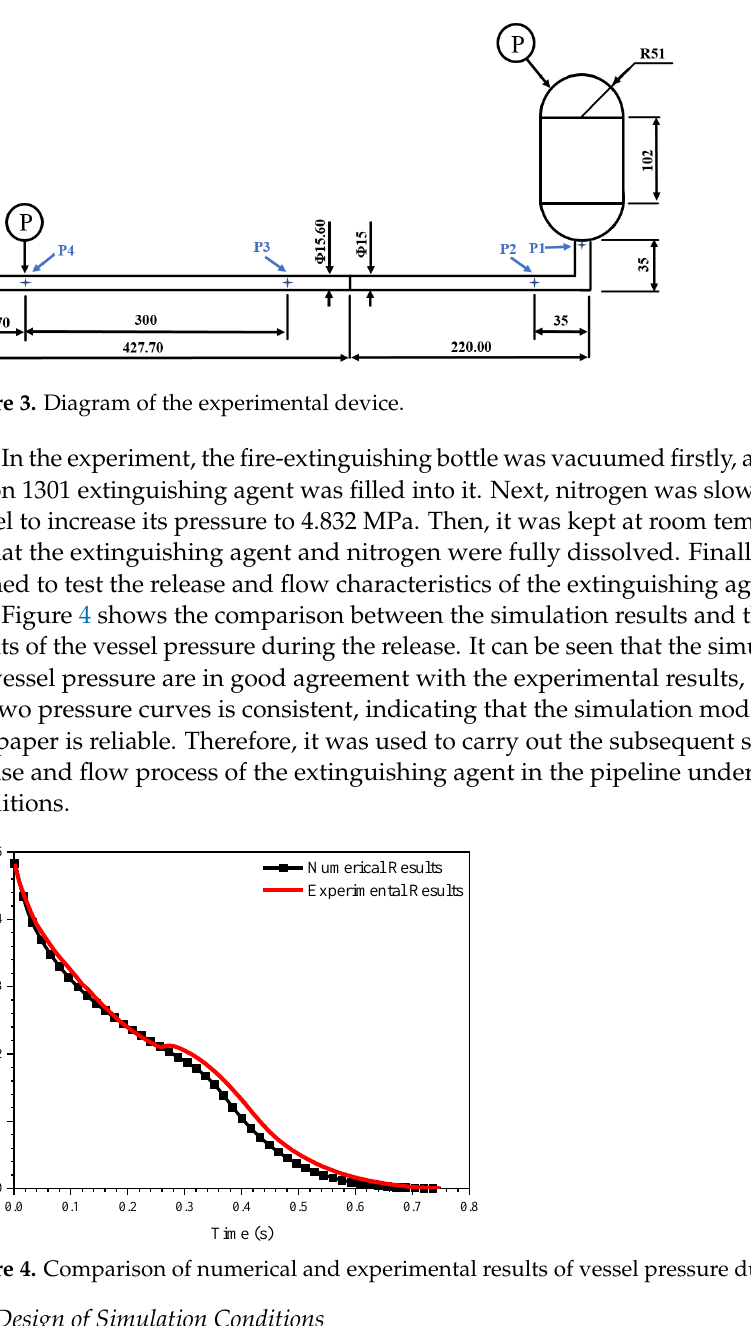
Table 1. Initial state of the extinguishing bottle under different filling pressures. Filling Pressure / MPa